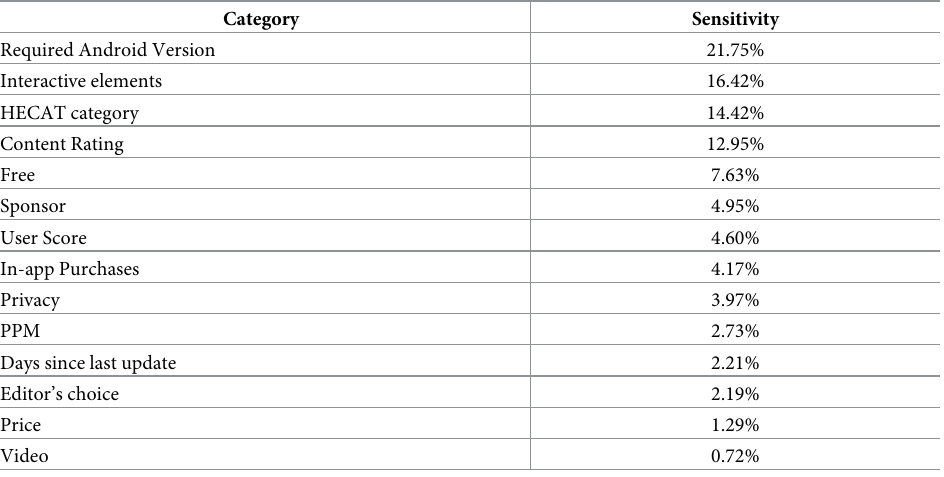
Table 5. ANN sensitivity (excluding description text